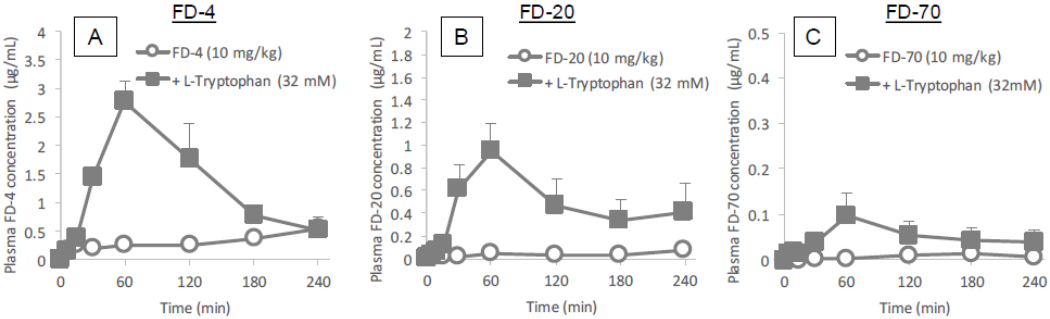
Figure 3. Time profiles of plasma concentrations of model hydrophilic macromolecules (FD-4, FD-20 and FD-70) after their in situ administration with or without L -tryptophan (32 mM) into rat ileal loop. Panels ( A – C ) show the absorption of FD-4, FD-20 and FD-70, respectively. Each data point represents the mean ± SEM of N =